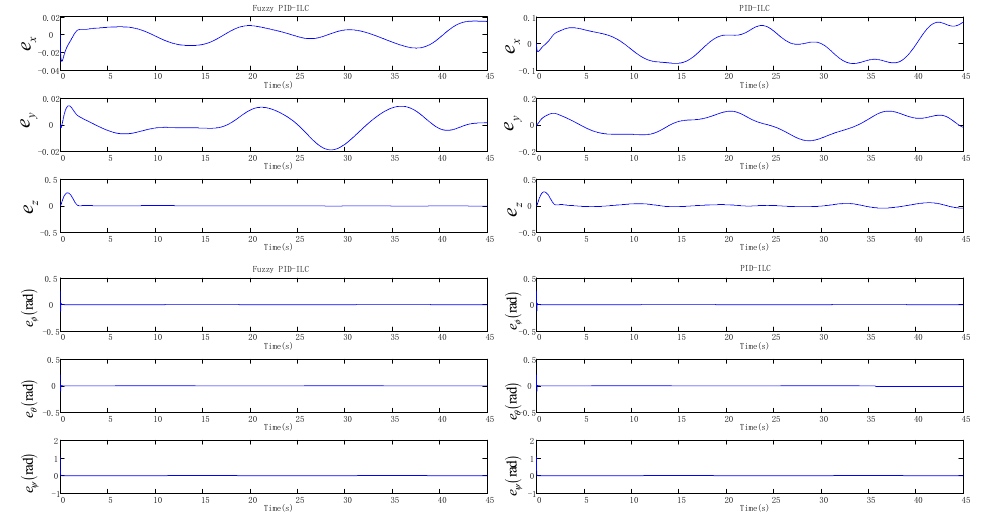
Figure 8. The changing curves of the tracking errors in the final iteration.